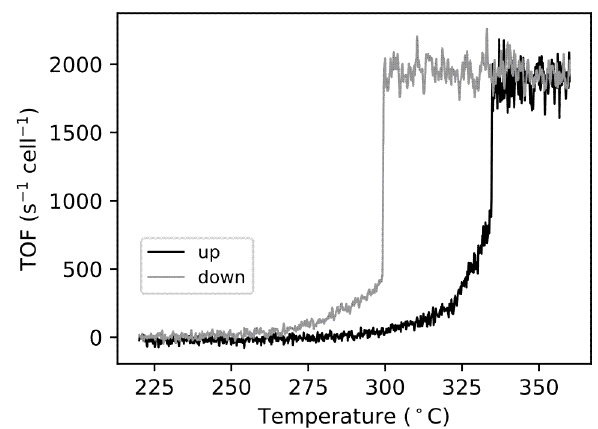
Figure 4. TOF as a function of temperature in the up and down branches.